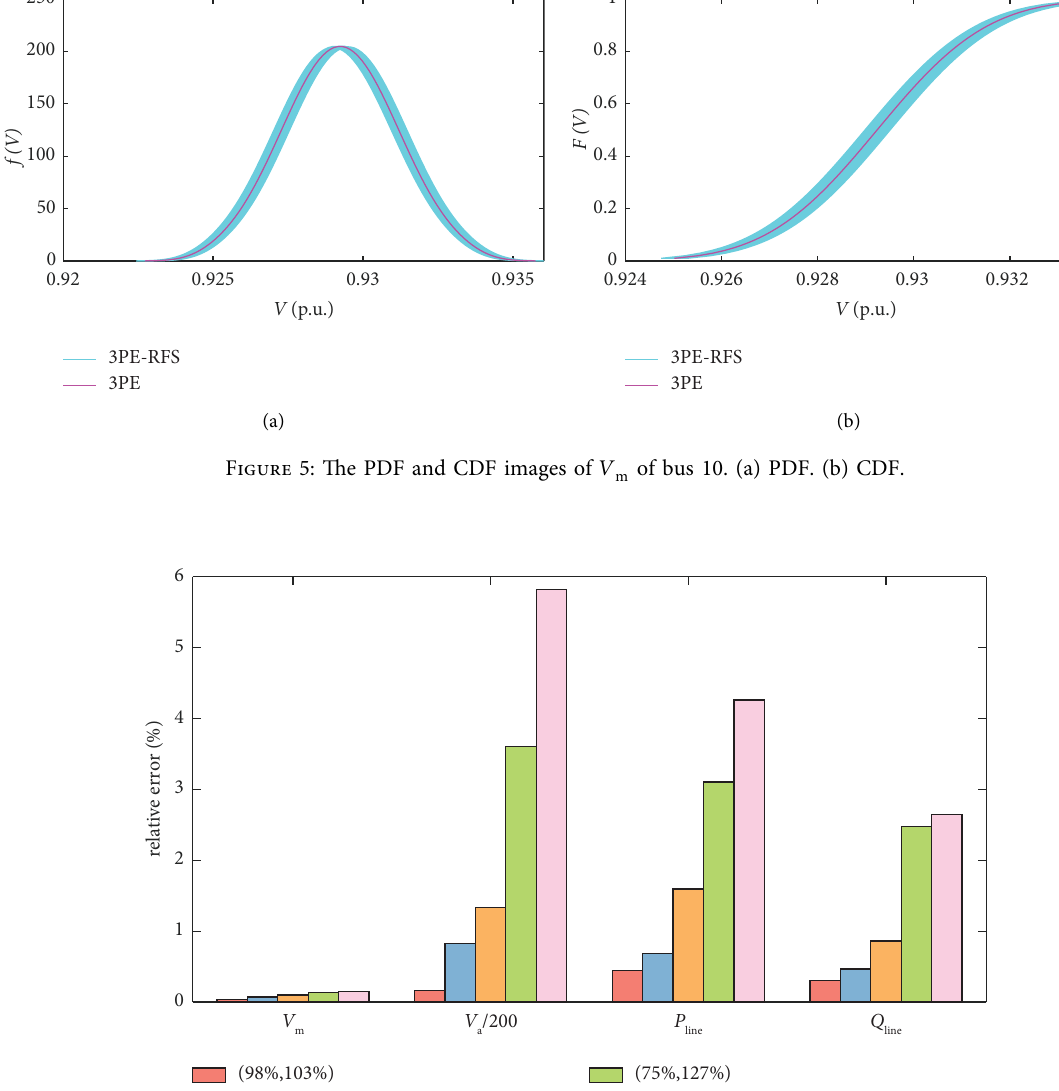
with diferent ranges of fuzzy ∗